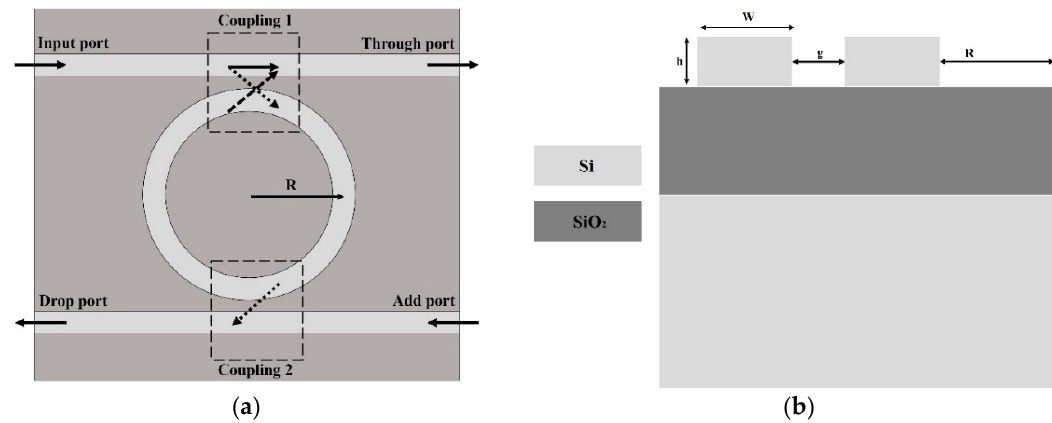
Figure 1. Illustration of the proposed design of the microring (MRR) shows ( a ) configuration of add-drop system ports and ( b ) the cross-section of the MRR based on Silicon-on-Insulator (SOI) material.